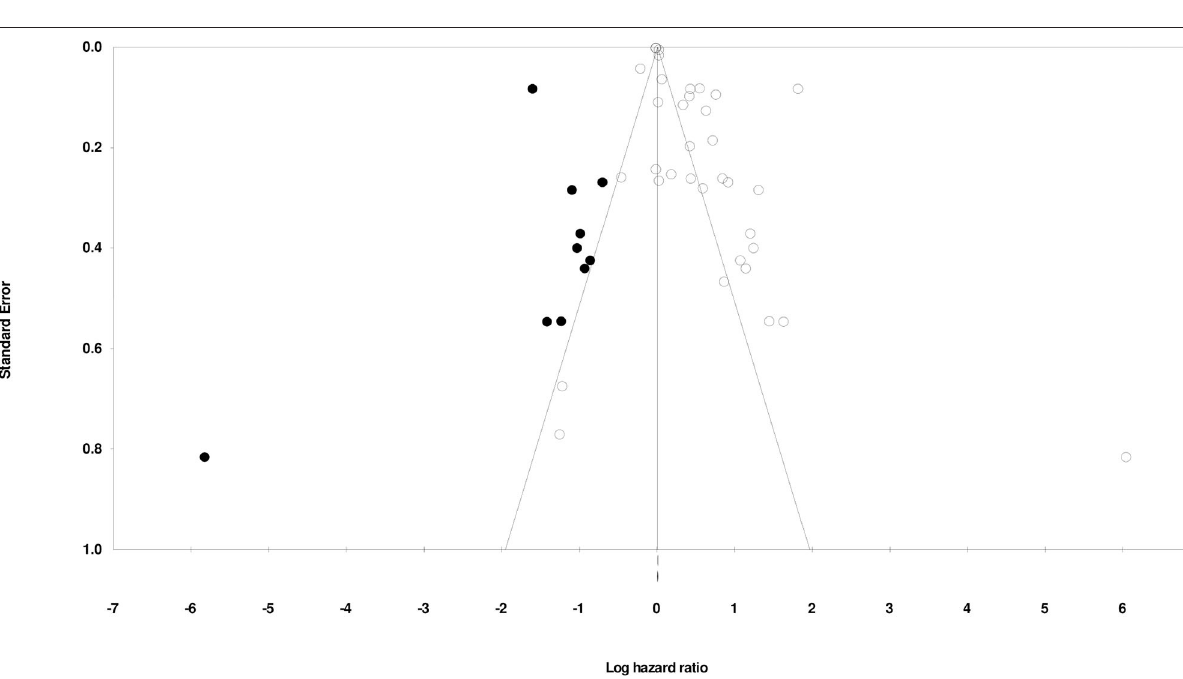
FIGURE 3 | Demonstrates the publication bias by Duval & Tweedy’s trim and fill